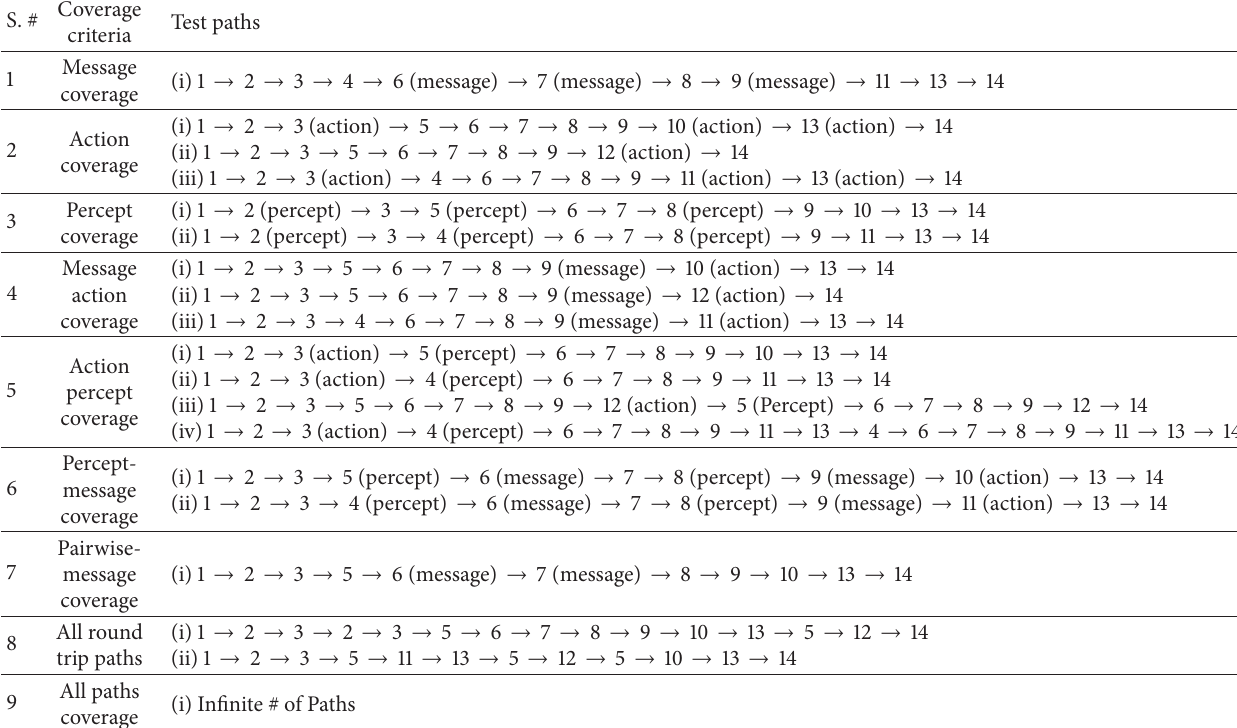
Table 1: Test paths for account operation protocol